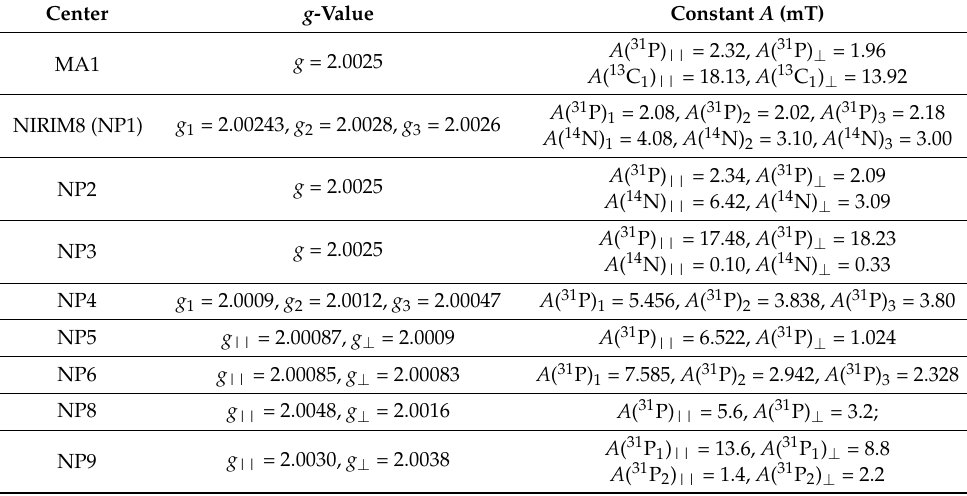
Table 5. EPR parameters of the phosphorus-containing centers with S = 1/2 in diamond [46,48]. Center g -Value Constant A (mT) MA1 g =